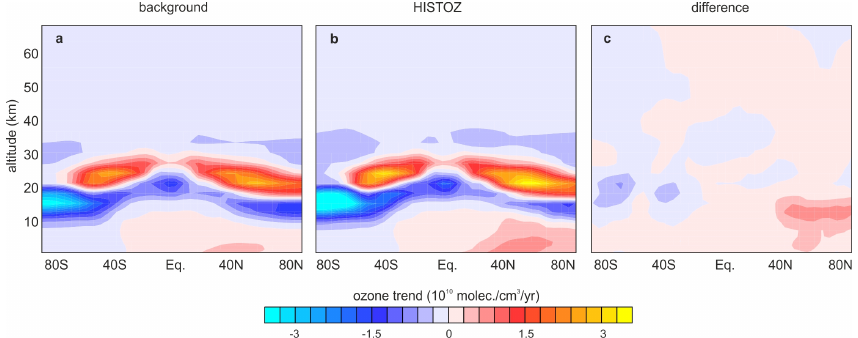
Fig. 13. Trends in annual mean zonal-mean ozone from 1957 to 1970 for (a) the background, (b) HISTOZ.1.0 and (c) the difference HISTOZ.1.0 minus background.